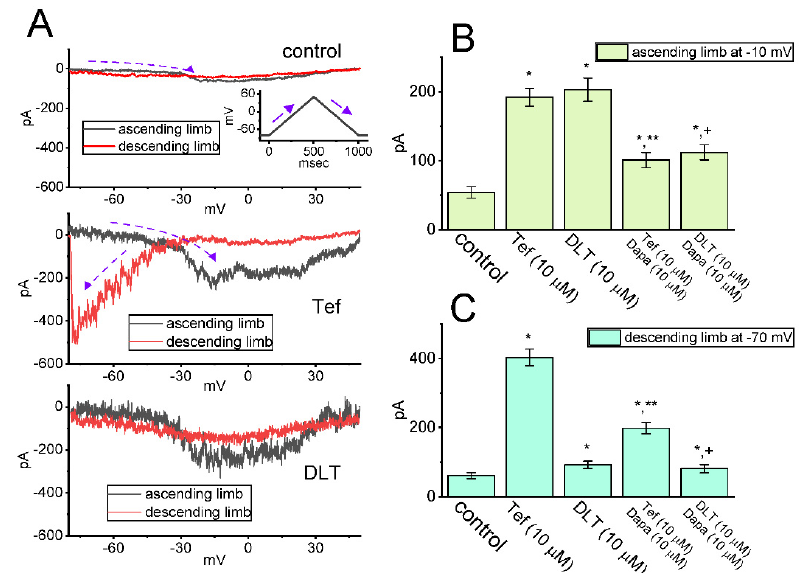
Figure 7. Modifications by Tef or DLT on the strength of voltage-dependent hysteresis (Hys (V) ) in persistent I Na ( I Na(P) ) present in GH 3 cells. In this set of whole-cell current recordings, the examined cell was voltage-clamped at − 80 mV and we then delivered the isosceles-triangular ramp voltage (V ramp ) for a duration of 1 s (i.e., a ramp speed of ±0.26 mV/ms) to activate I Na(P) . ( A ) Exemplar current traces obtained in the control period (upper) and in the presence of 10 μ M Tef (middle) or 10 μ M DLT (lower). The ascending (upsloping) limb is indicated in black color, where the descending (downsloping) one is in the red color. Inset in the upper part of ( A ) shows the voltage-clamp protocol applied, whereas the dashed arrow indicates the direction of potential or current trajectory by which time goes. In ( B ) or ( C ), summary bar graph, respectively, demonstrates the effect of Tef (10 μ M), DLT (10 μ M), Tef (10 μ M) plus Dapa (10 μ M), and DLT (10 μ M) plus Dapa (10 μ M) on I Na(P) amplitude activated by upsloping (at − 10 mV) or downsloping limb (at the level of − 70 mV) of double V ramp (mean ± SEM; n = 8 for each bar). * Significantly different from control ( p < 0.05), ** significantly different from Tef (10 μ M) alone group ( p < 0.05), and + significantly different from DLT (10 μ M) alone group ( p < 0.05).